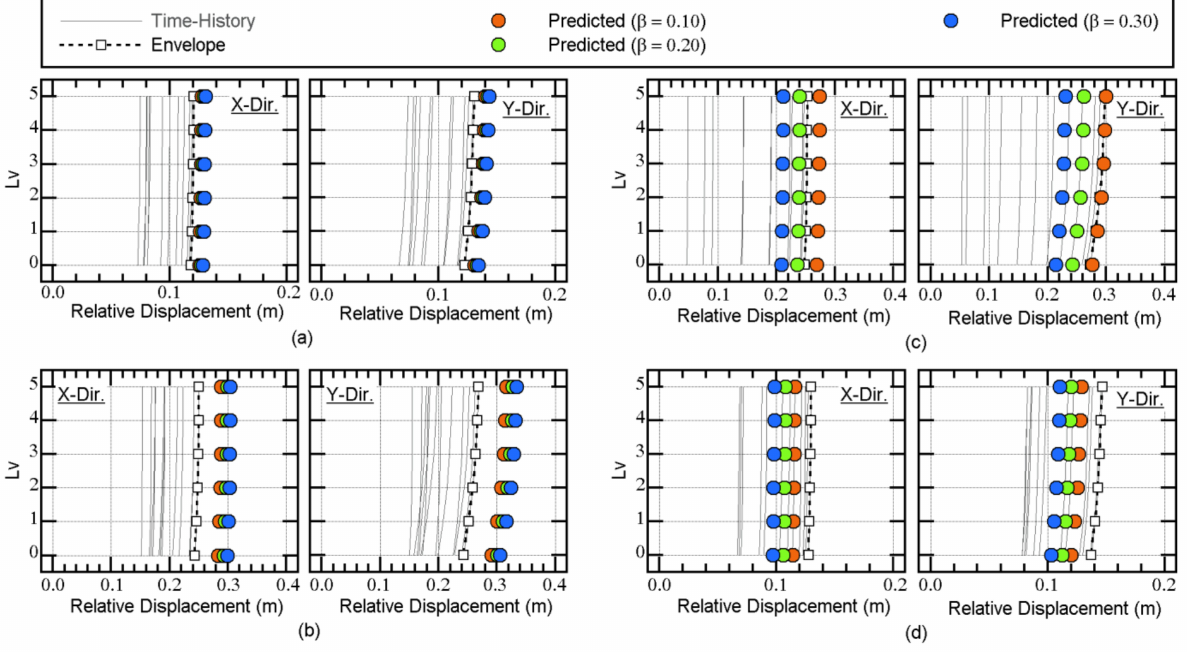
Figure 24. Comparison of the peak relative displacements at X 3A Y 3 (Model-Tf34): ( a ) UTO0414; ( b ) UTO0416; ( c ) TCU; ( d )